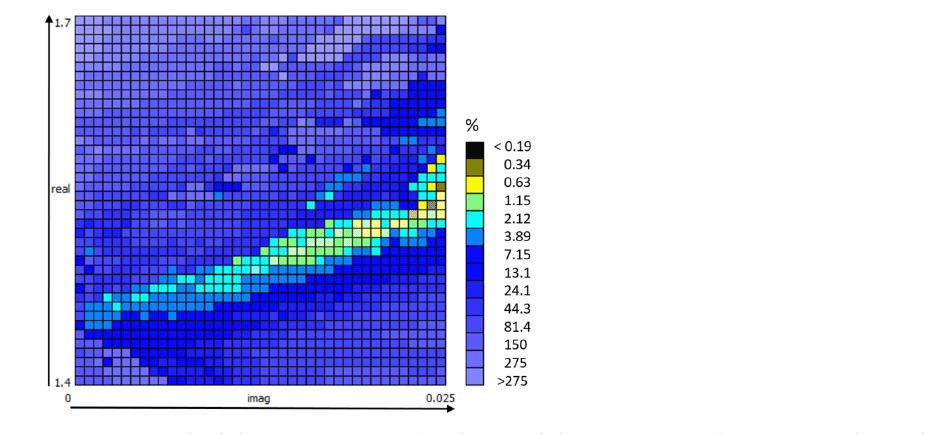
Figure 1. Grid of the imaginary and real part of the CRI at 21 February 2020, lower layer from 1323 until 1586 m. The selected grid points in the diagonal pattern to determine the mean CRI are marked brightly.